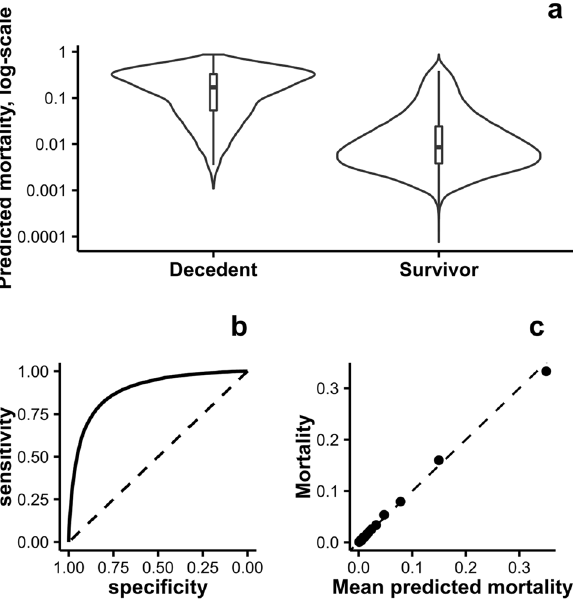
Figure 2. Description of the one-year mortality predictions for the test sample. Violin plot of the distribution of predicted mortalities for survivors and decedents ( a ), ROC curve ( b ), calibration plot ( c ).